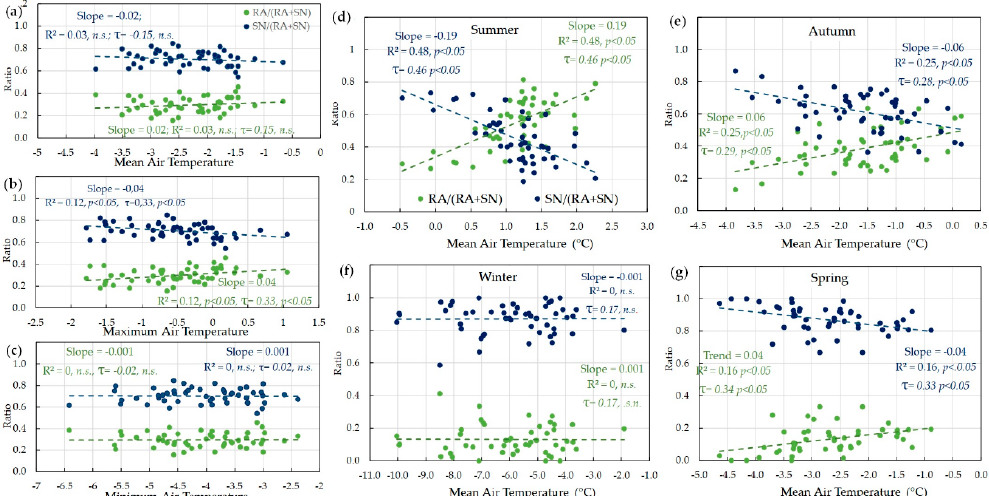
Figure 8. Annual ( a – c ) correlations between Mean Air Temperature, Maximum Air Temperature and Minimum Air Temperature, with the ratios of RA / (RA + SN) and SN / (RA + SN). Seasonal ( d – g ) correlations between Mean Air Temperatures and the ratios of RA / (RA + SN) and SN / (RA + SN). All at Frei